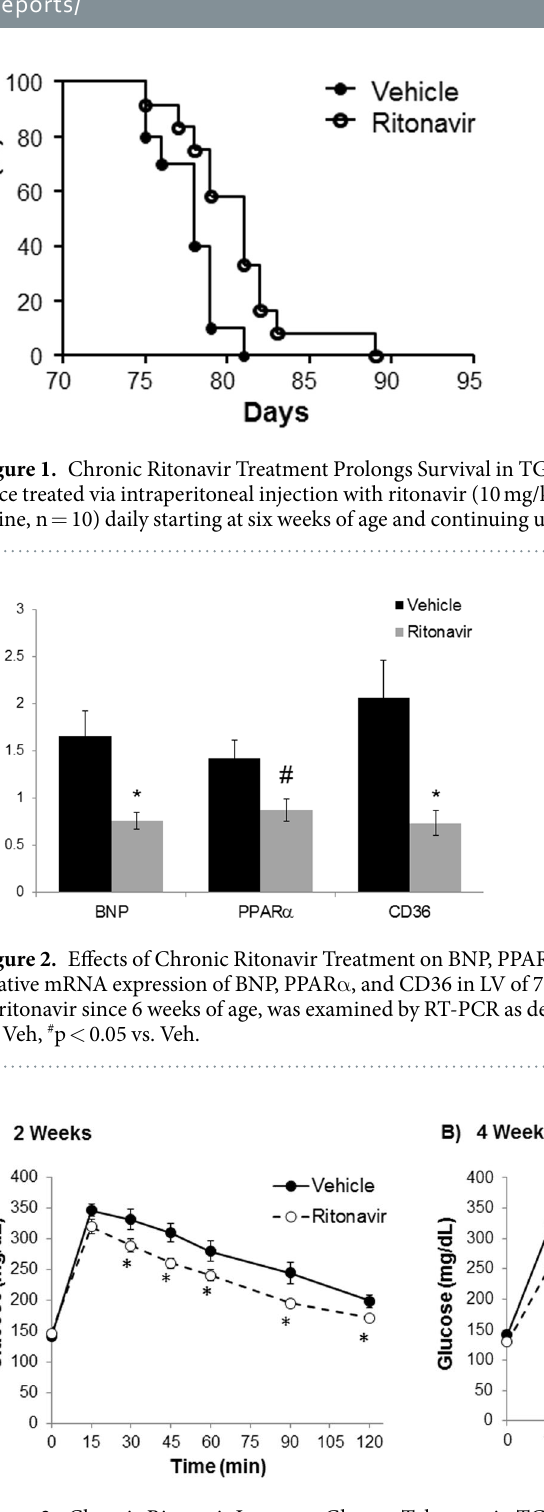
Figure 3. Chronic Ritonavir Improves Glucose Tolerance in TG9 Mice. Oral glucose tolerance test was performed on male TG9 mice at ( A ) 8 weeks of age (2 weeks treatment) and, ( B ) 10 weeks of age (4 weeks treatment) following a 5 hr fast and as described in Methods. n = 10–12/group. * p < 0.05 vs.